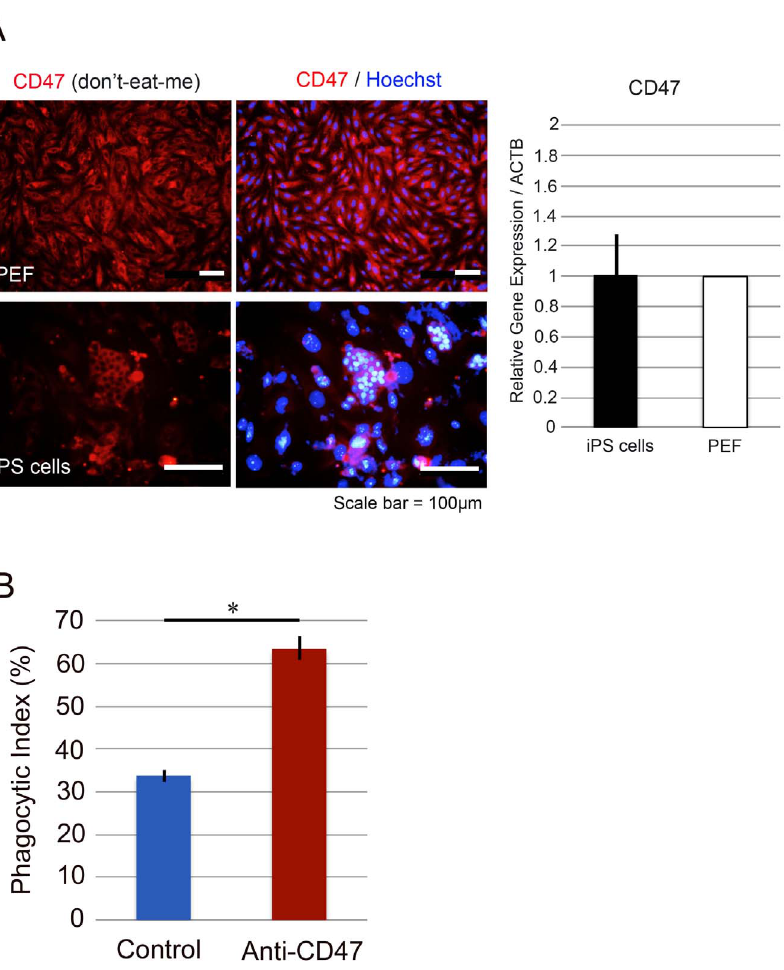
Figure 4. C1 iPS cells evade phagocytosis by macrophages through CD47 ligand. (A) Expression of CD47 was evaluated by immunocytochemistry and semi-quantitative PCR ( n =3). C1 iPS cells expressed CD47 to the same extent as fibroblasts. (B) Phagocytosis index (PI) was the number of iPS cells phagocytosed per 100 iPS cells, and it was 33.7 6 1.5%. The anti-CD47 antibody was then used to block the binding of CD47 to SIRP a . The PI value increased to 63.4 6 2.8%, showing that CD47 is responsible for the escape of iPS cells from phagocytosis by macrophages ( * p , 0.01).